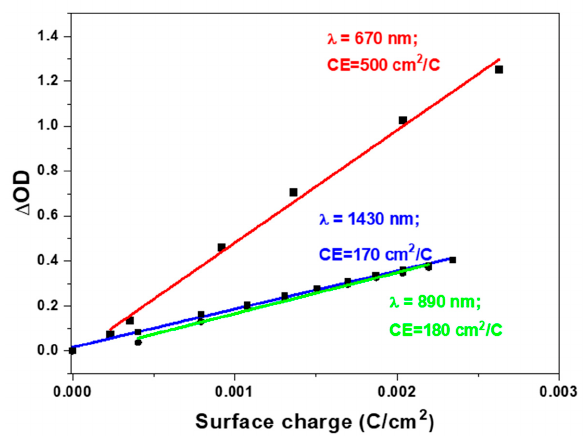
Figure 3. Optical density versus charge density of the EC devices containing the Fc/TV (electroactive area of 2.3 cm 2 ) and MV/TV systems (electroactive area of 4 cm 2 ).